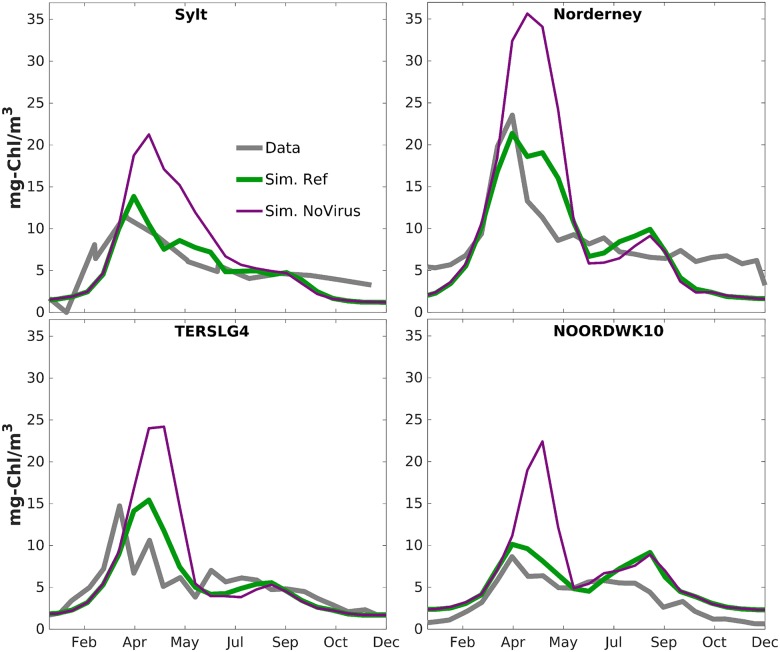
Climatological phytoplankton dynamics.Long-term (2000-2014) averaged chlorophyll concentration at four near-shore stations as calculated from observed time-series (grey), simulated using the standard parametrization (green) or neglecting viral infections (magenta).